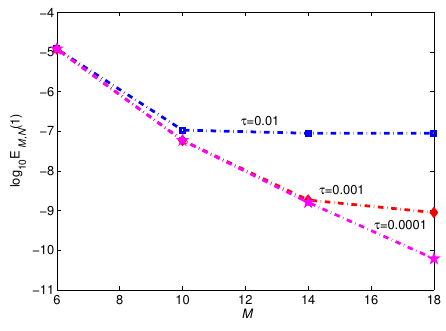
Figure 1. log 10 E M,N (1) vs M of scheme (3.5) for (3.2) with different τ .